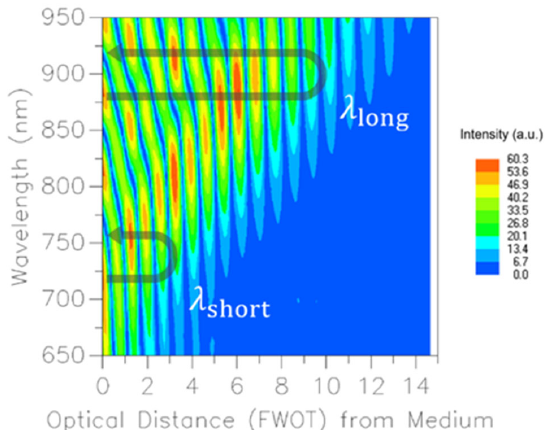
Figure 8. Plots of optical properties of the coatings vs. wavelength of the optimal film design.